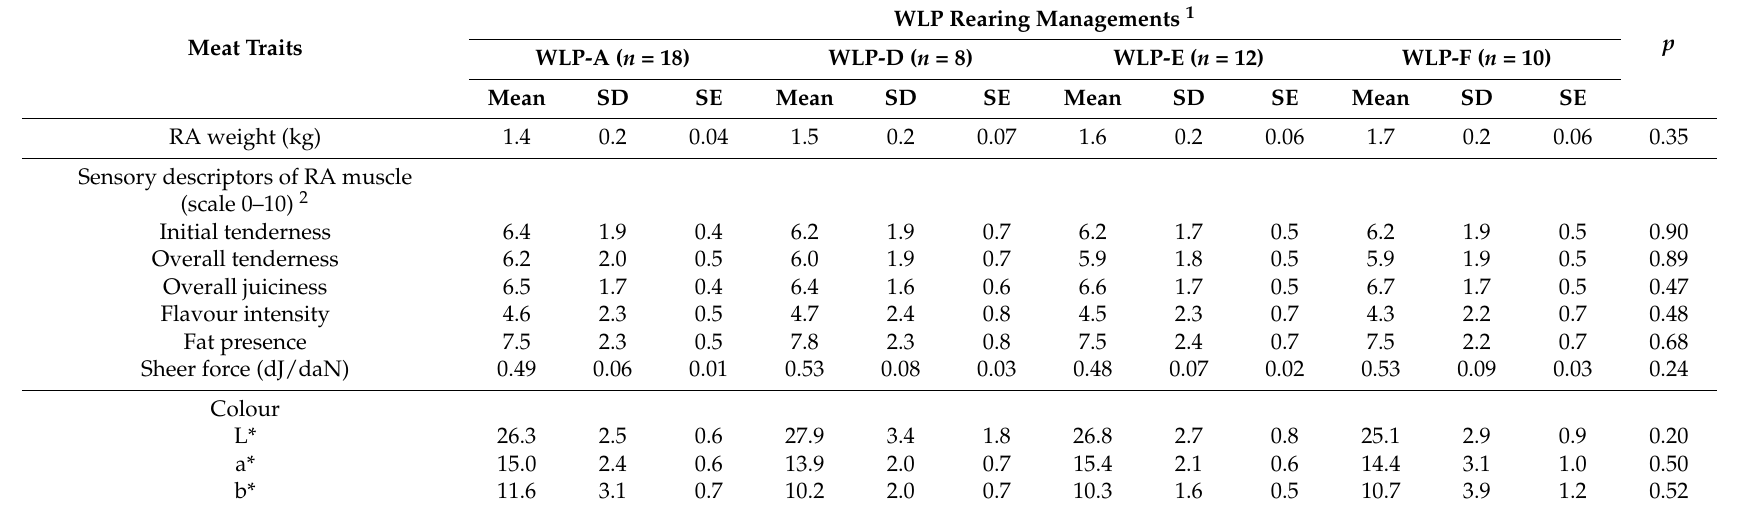
Table 6. Impact of the four rearing managements applied during the heifers’ whole life period (WLP) on flank steak (rectus abdominis, RA) traits.